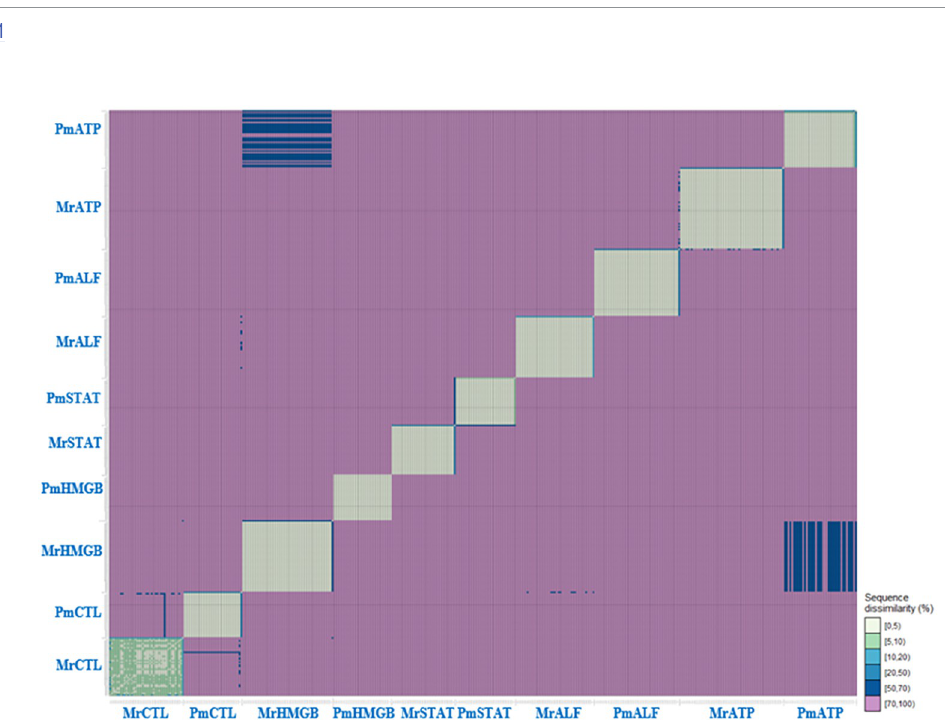
Fig 1. Display of genetic differentiation between different genes of total cDNA sequences. Mr: M . rosenbergii ; Pm: P . monodon . Genes: C-type Lectin (CTL), HMGB, STAT, ALF3 (ALF), ATPase 8/6